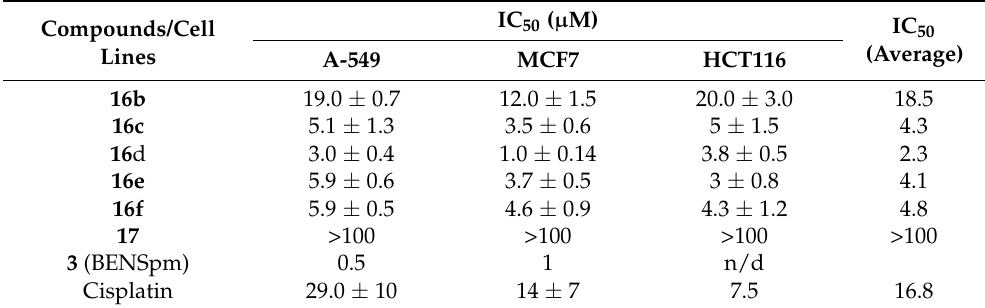
Table 1. Values of cell viability after PA ( 16b – f ) treatment